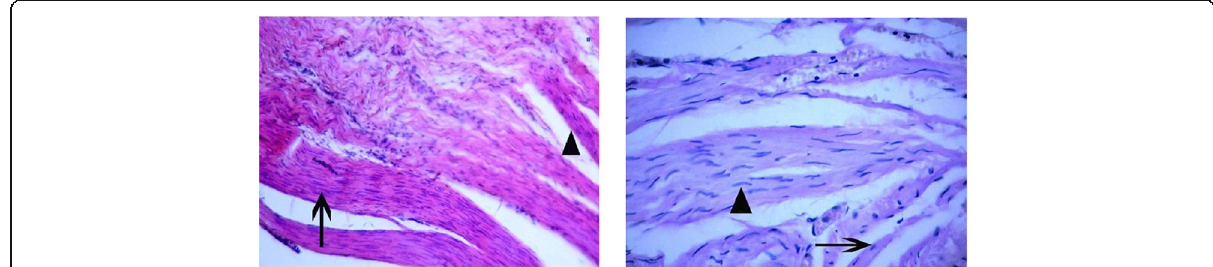
Fig. 3 Predominance of the transverse collagen fibres in the right and left borders of the ring of the indirect umbilical hernia (the arrow points to transverse fibres while the arrowhead points to the oblique fibres)